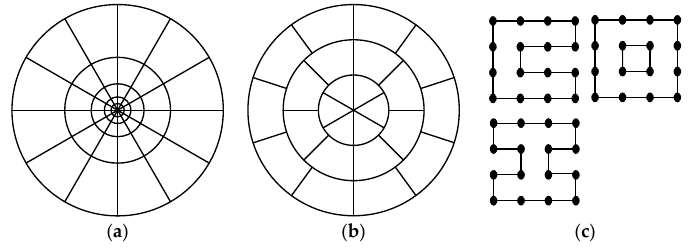
Figure 7. ( a ) The log-polar histogram bins; ( b ) the proposed histogram binning strategy; ( c ) several different shapes constituted by the same points.